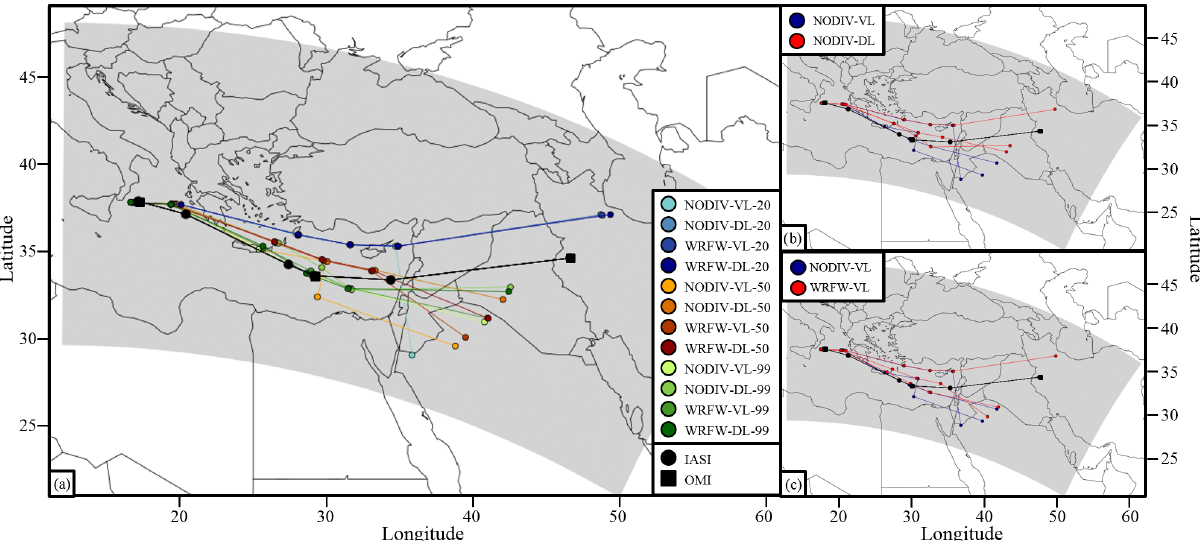
Figure 4. Mount Etna volcanic plume transport over the Mediterranean Sea after the 18 March 2012 eruption. The satellite trajectory (black line) was built by combining information from the IASI and OMI instruments. (a) Transport for all simulations, (b) plume transport highlighted according to the vertical scheme and (c) plume transport highlighted according to the vertical wind strategy. The points along the trajectories correspond to those listed in Table 3.